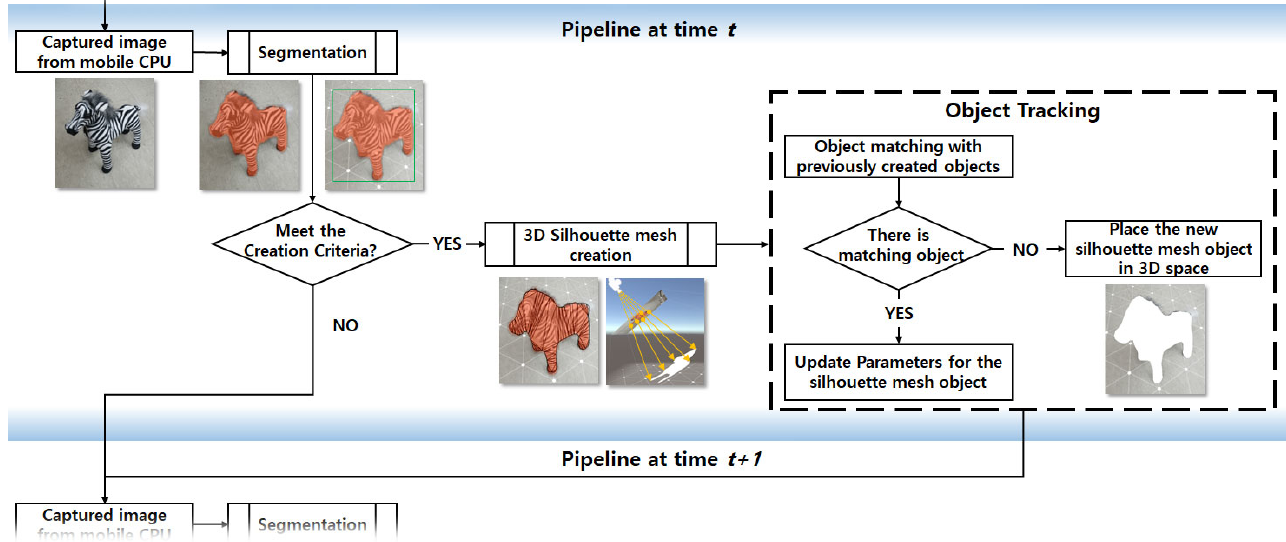
Figure 5. Overview of our system’s main pipeline and detailed silhouette mesh update